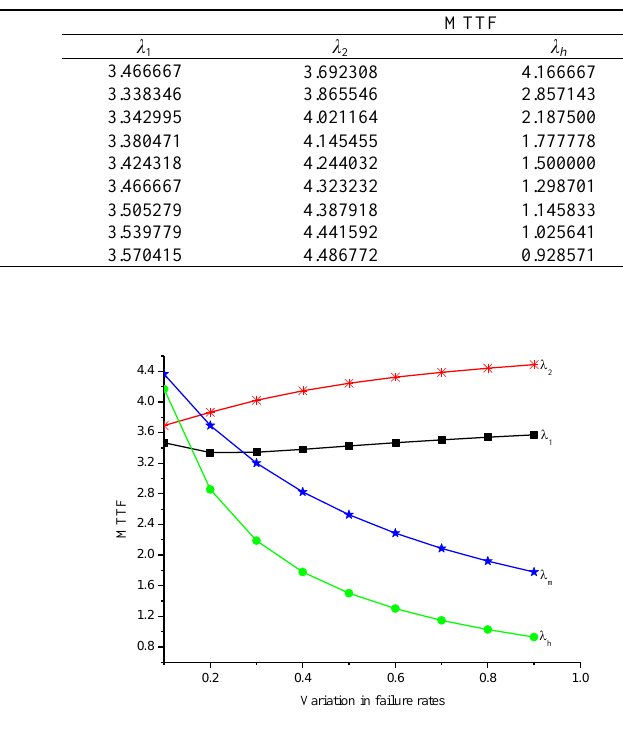
Figure 11. MTTF of the system with copula.